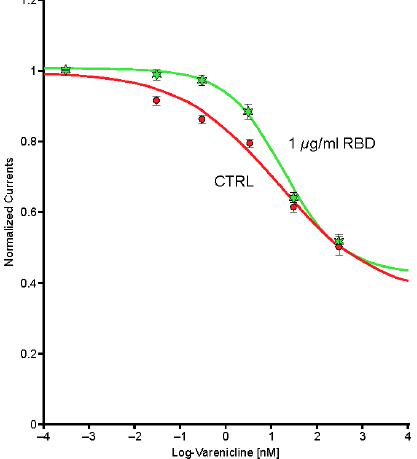
Figure 11. Concentration-response curve to acetylcholine (ACh) in the absence or presence of omicron. Typical currents were recorded in the same cell before (green traces) and during exposure to the protein (red traces). Currents were elicited by brief exposure to ACh test pulses with a series of concentrations. Currents were normalized to unity vs. the maximal value and average results obtained in five cells were plotted vs. the logarithm (log) of the ACh concentration. The green curve is the best fit obtained with the Hill equation. Areas under the curve are plotted on the lower right-hand side. log, logarithm.